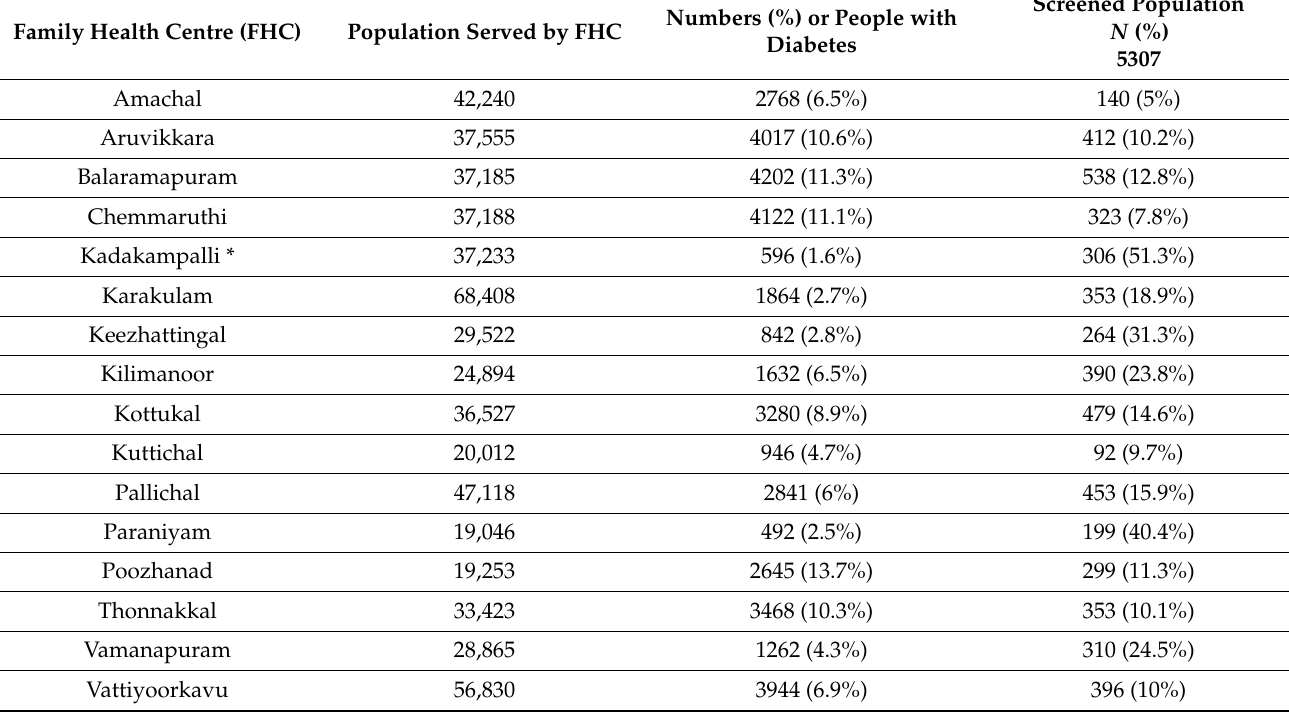
Table 1. The representativeness of the sample at each FHC.